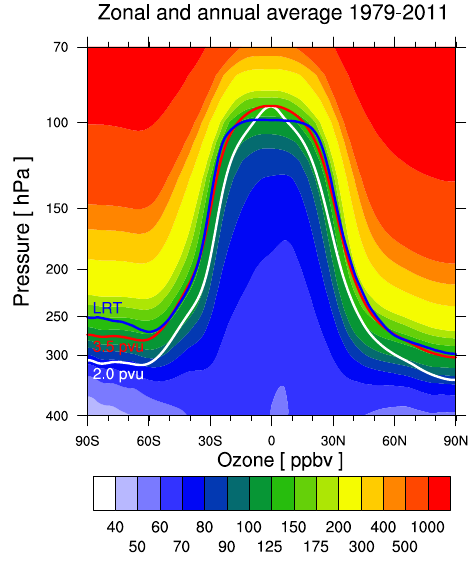
Fig. 15. Zonal and annual average of ozone mixing ratio and dif- ferent tropopause definitions in ERA-Interim for 1979–2011. The blue, red, and white lines show the lapse-rate tropopause as de- fined by the WMO (“LRT”), the 3.5pvu/380K control surface (“3.5pvu”) and the 2pvu/380K dynamical tropopause (“2.0pvu”), respectively. Note the non-linear colour